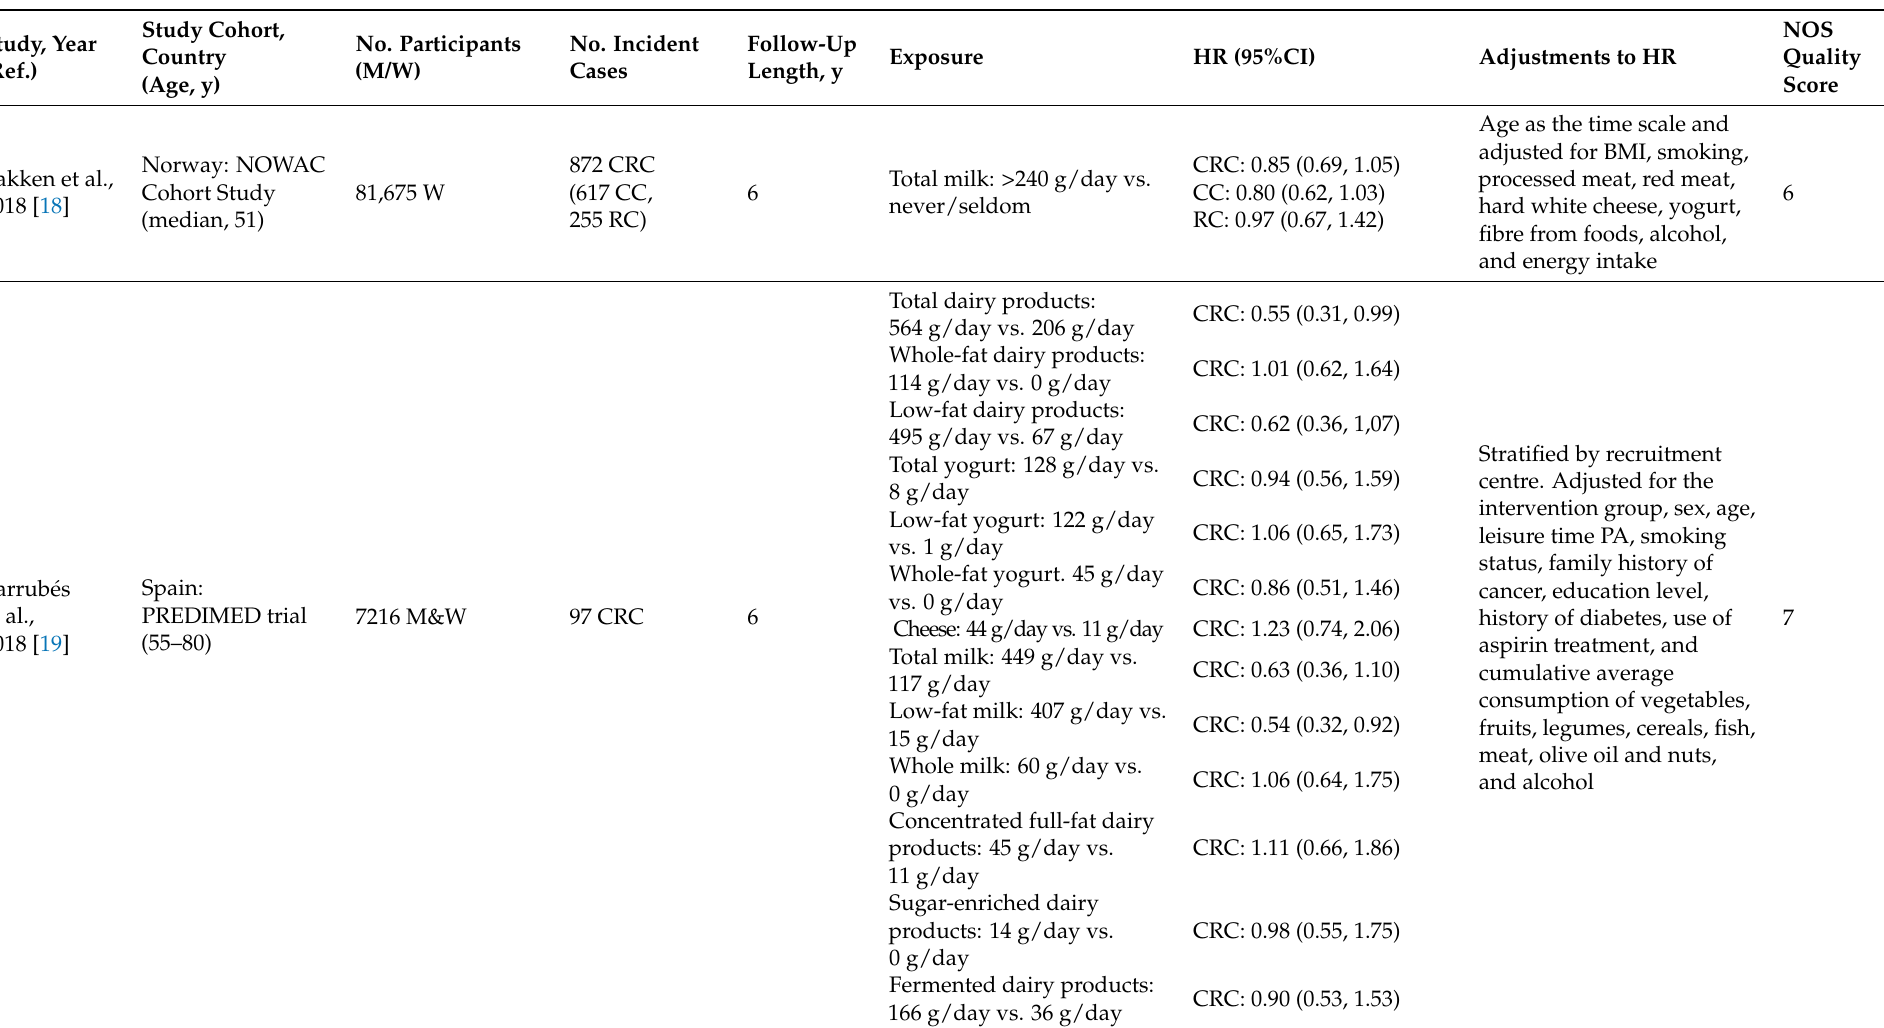
Table 1. Characteristics of the ten cohort studies included in the systematic review examining the association between the consumption of dairy products and the risk of colorectal